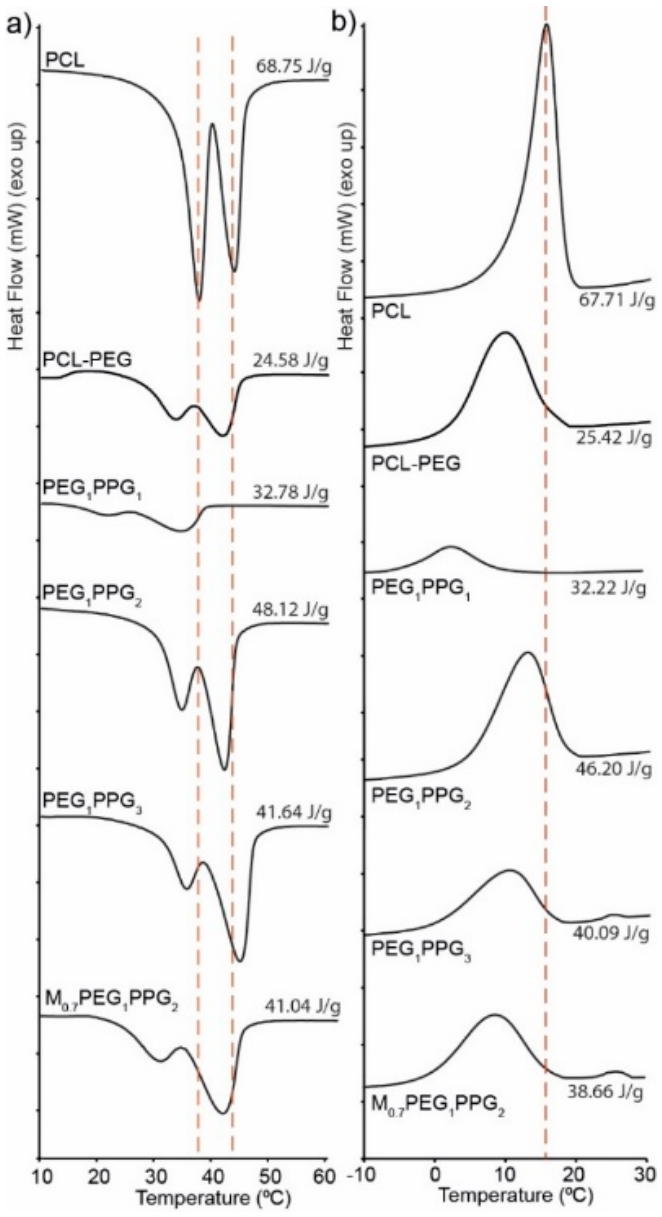
Figure 3. DSC thermograms of a PCL homopolymer and the copolymers showing ( a ) melting peaks and ( b ) crystallising peaks obtained on the second heating and cooling cycles,